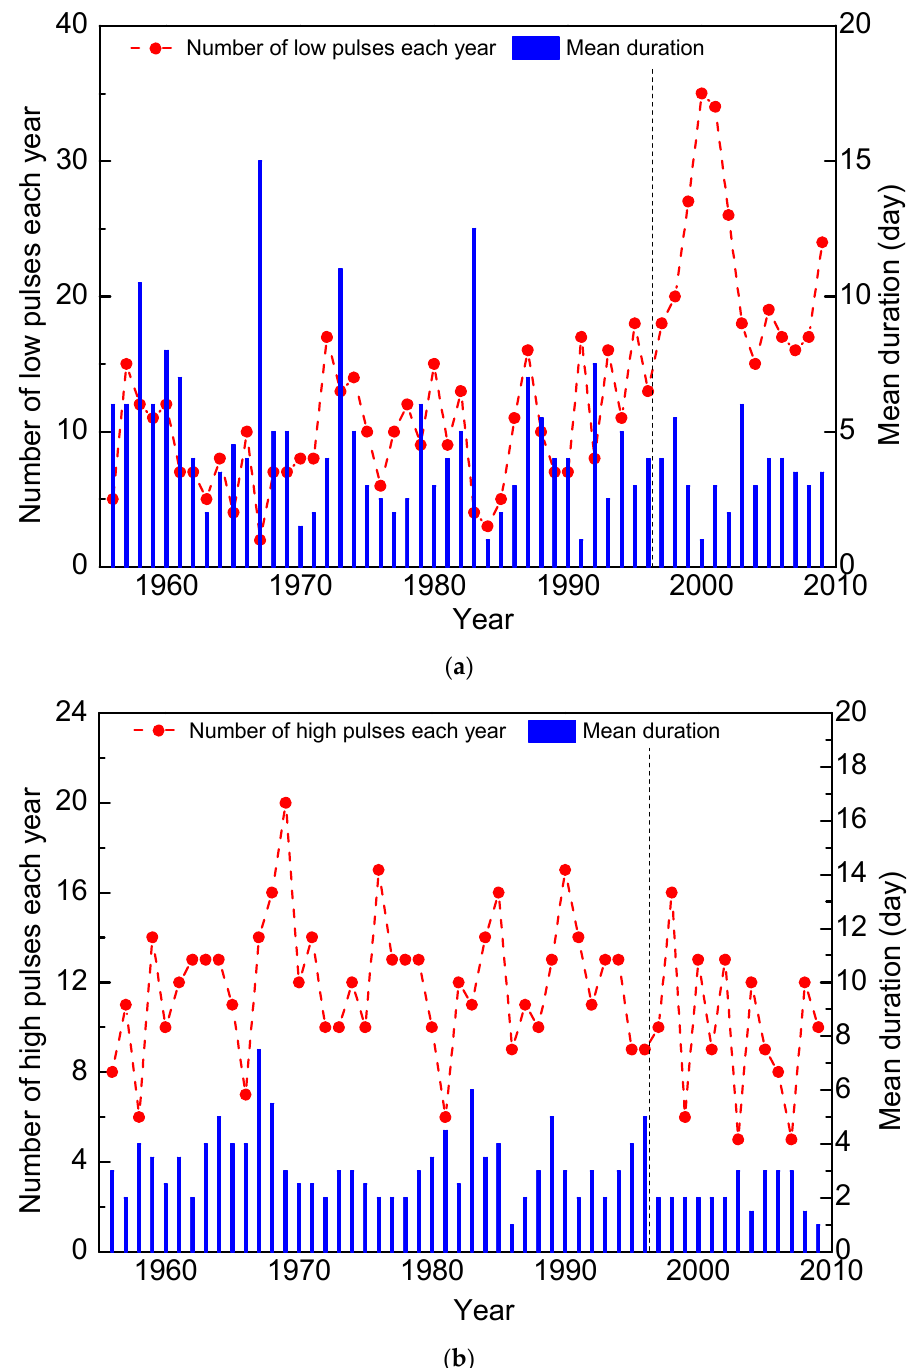
Figure 6. Number and mean duration of ( a ) low and ( b ) high pulses each year at Zhangjiashan Station (the outlet of Jinghe Basin).